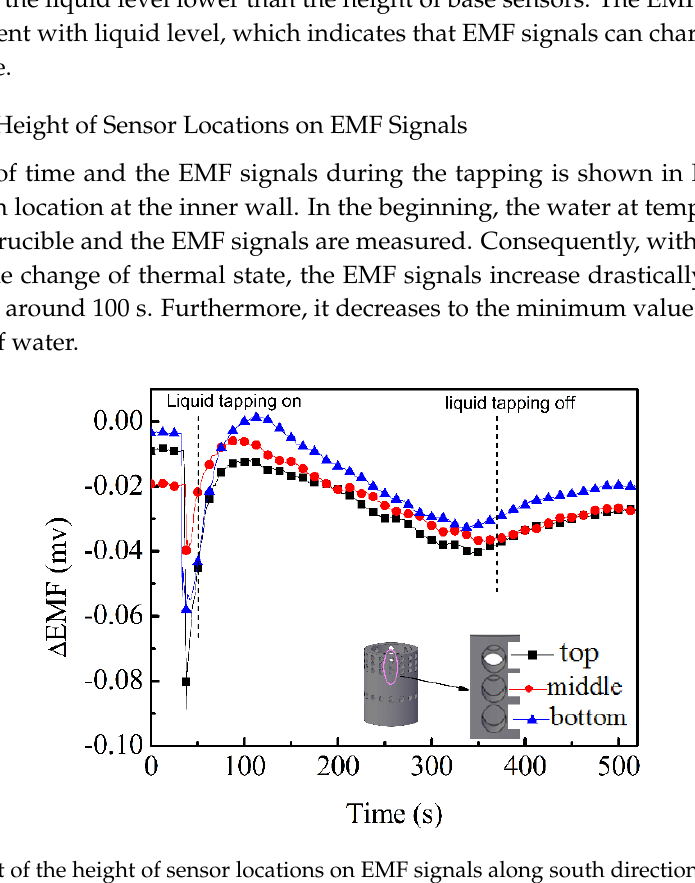
Table 1. Summary of EMF signals at different locations at inner wall and outer wall.